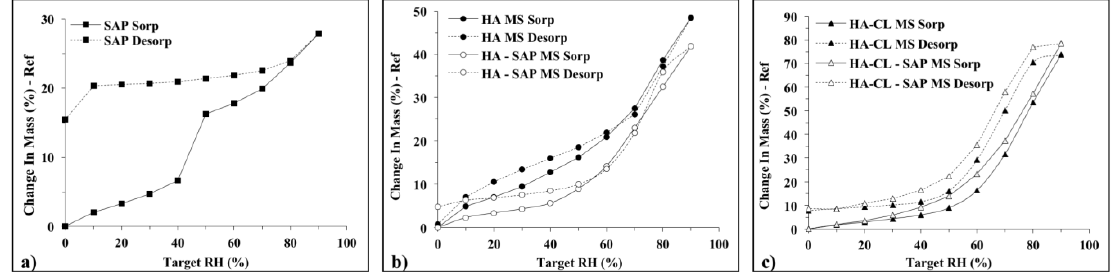
Figure 7. DVS isotherms of the first cycle sorption-desorption for: SAP ( a ), HA MS and HA–SAP MS ( b ), HA-CL MS and HA-CL–SAP MS ( c ).